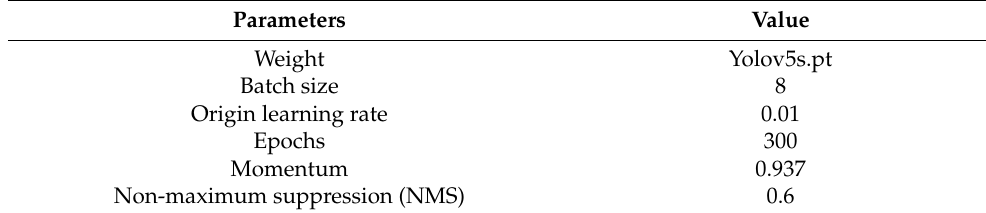
Table 1. Training parameters of